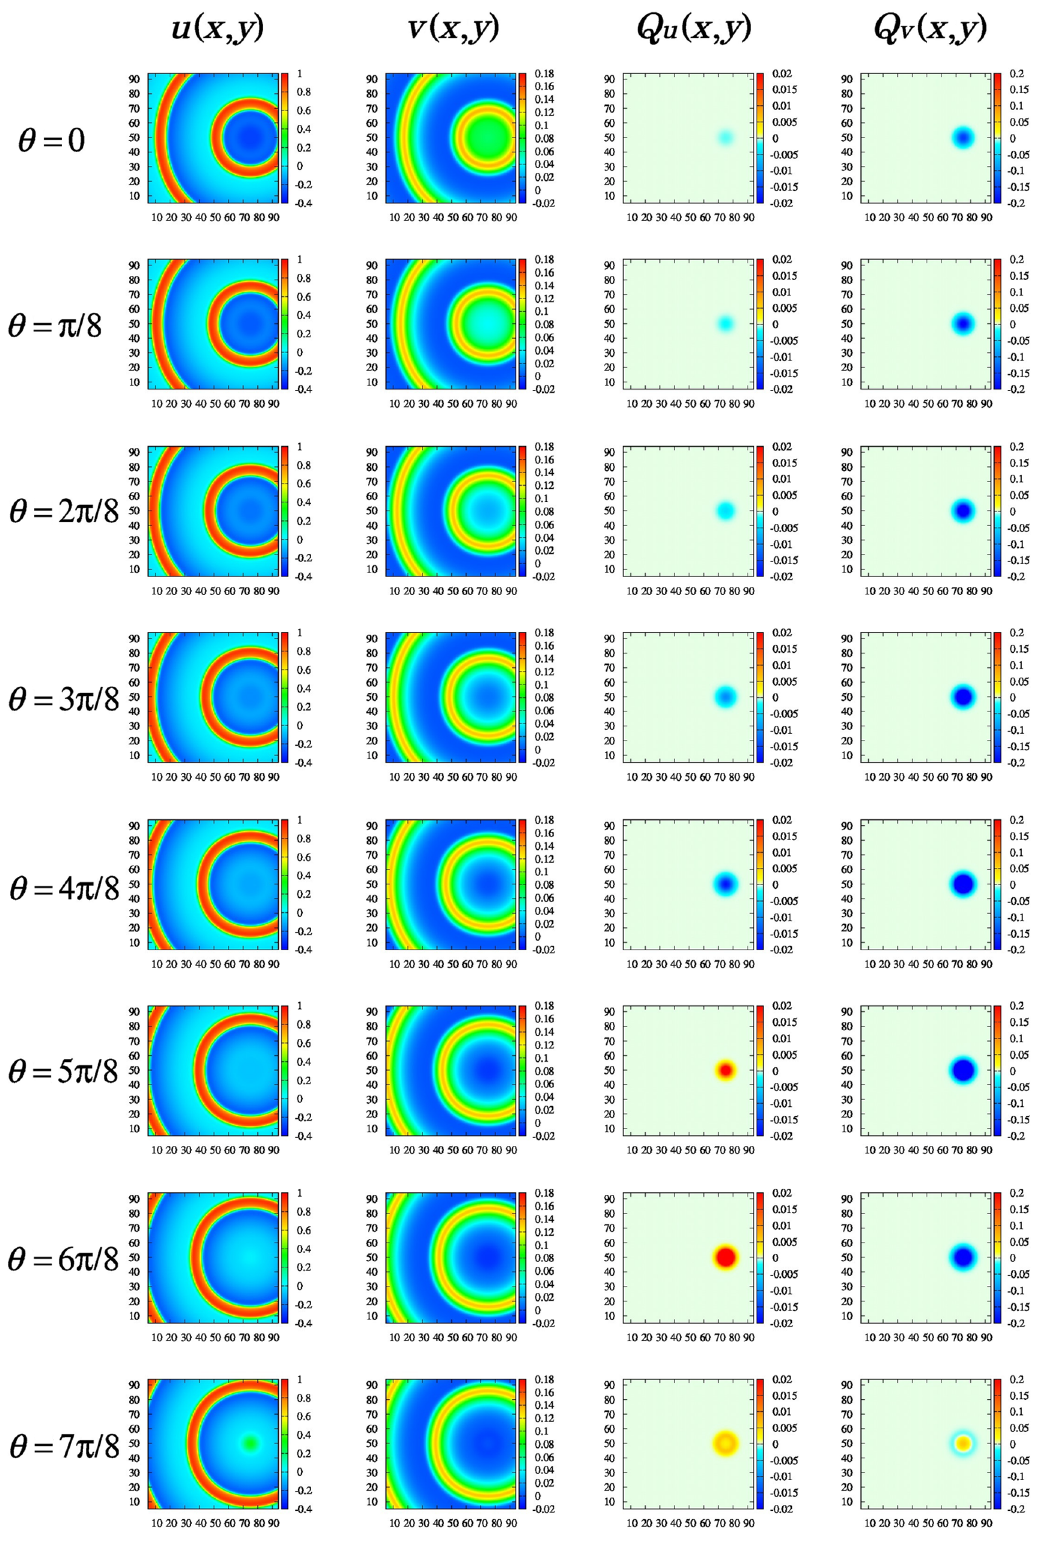
FIG. 7. Limit-cycle solution X 0 ð r ; θ Þ and phase-sensitivity function Q ð r ; θ Þ of the target wave for θ ¼ 0 ; π = 8 ; 2 π = 8 ; … ; 7 π = 8 . First column: Activator ( u ) component of X 0 ð r ; θ Þ . Second column: Inhibitor ( v ) component of X 0 ð r ; θ Þ . Third column: u component of Q ð r ; θ Þ . Fourth column: v component of Q ð r ; θ Þ . The parameters are the same as in Fig.